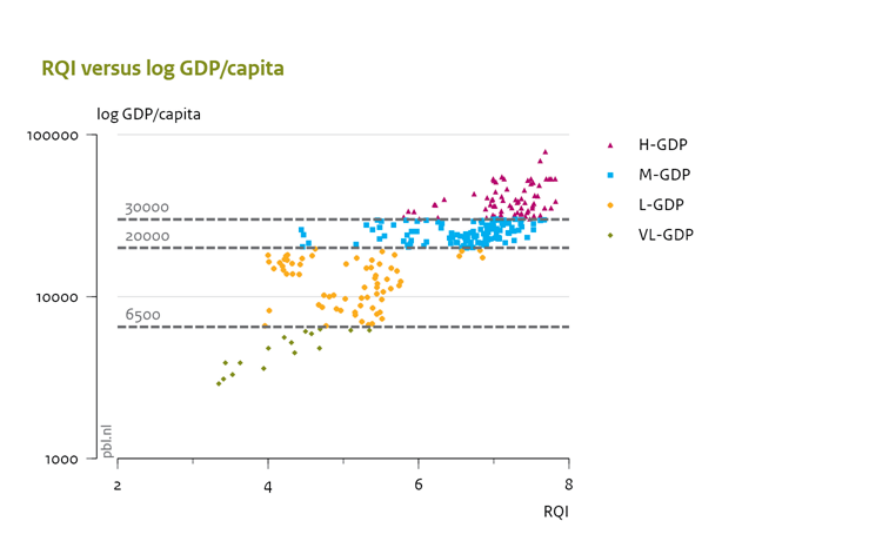
Figure 5: Average score of Regional Quality of Living Indicators vs several classes of regional GDP per capita